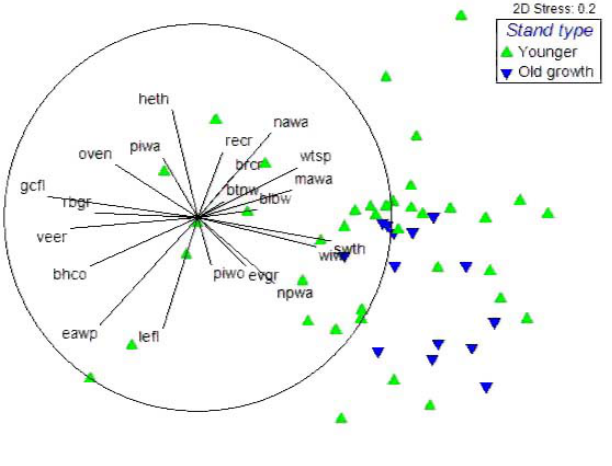
Fig. 4 . Nonmetric multidimensional scaling plot of pine stands showing old-growth stands and mature stands. Species with Pearson correlations of >0.45 with axes: bhco (Brown-headed Cowbird); eawp (Eastern Wood-pewee); gcfl (Great-crested Flycatcher); heth (Hermit Thrush); lefl (Least Flycatcher); mawa (Magnolia Warbler); mowa (Mourning Warbler); nawa (Nashville Warbler); npwa (Northern Parula Warbler); oven (Ovenbird); rbgr (Rose- breasted Grosbeak); rbnu (Red-breasted Nuthatch); swth (Swainson's Thrush); veer (Veery); wiwr (Winter Wren); wtsp (White-throated Sparrow). Focal species: blbw (Blackburnian Warbler); brcr (Brown Creeper); btnw (Black-throated Green Warbler); evgr (Evening Grosbeak); piwa (Pine Warbler); piwo (Pileated Woodpecker); recr (Red